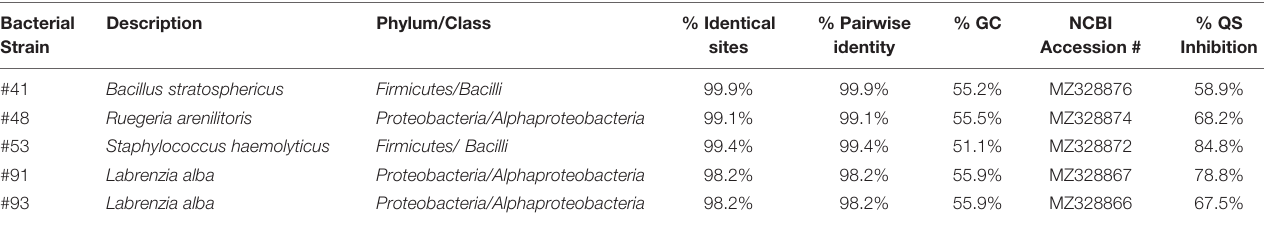
TABLE 4 | Overview of best BLAST hits of 16S rRNA gene from genomes of selected colonies of interest showing QSI activity. Bacterial